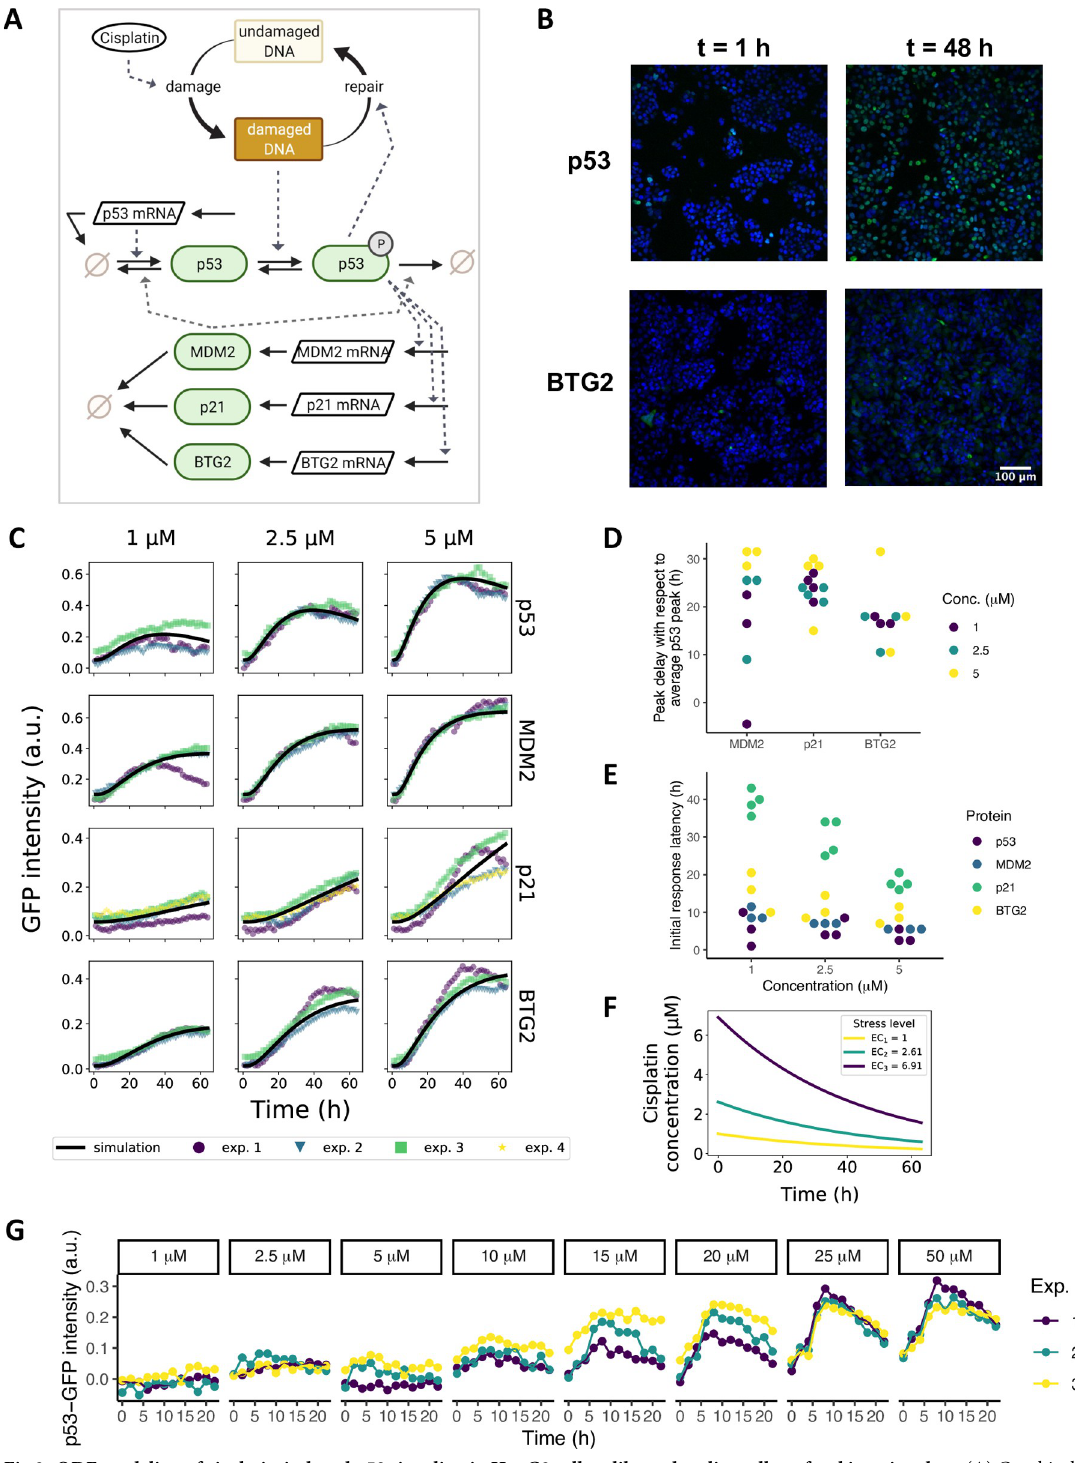
Fig 3. ODE modeling of cisplatin-induced p53 signaling in HepG2 cells calibrated on live cell confocal imaging data. (A) Graphical representation of the model. Cisplatin causes DNA damage, which triggers phosphorylation of p53. Phosphorylated p53 induces expression of its downstream targets MDM2, p21 and BTG2. (B) Example images of nuclear GFP expression in p53, and cytoplasmic GFP expression in BTG2 HepG2 BAC-GFP reporter cells at 1 and 48 hours. Blue, Hoechst-stained nuclei; green, GFP signal. (C) Mean of single-cell protein expression data measured over a 65-hour period after 1, 2.5 and 5 μ M cisplatin exposure. Experimental replicates